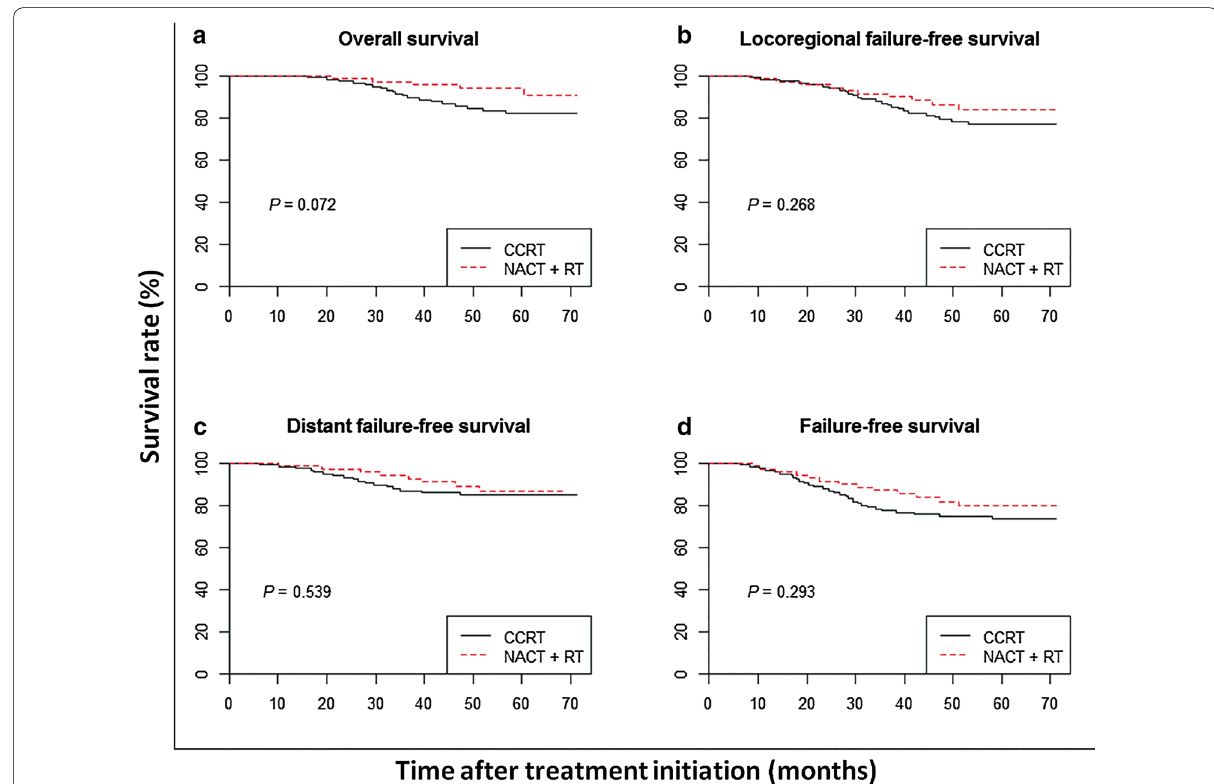
Fig. 1 Kaplan–Meier estimates of the survival of patients with the ascending type of nasopharyngeal carcinoma (NPC) treated with neoadjuvant chemotherapy plus subsequent radiotherapy (NACT RT) or with concurrent chemoradiotherapy (CCRT). a Overall survival; b locoregional failure‑ + free survival; c distant failure‑free survival; d failure‑free